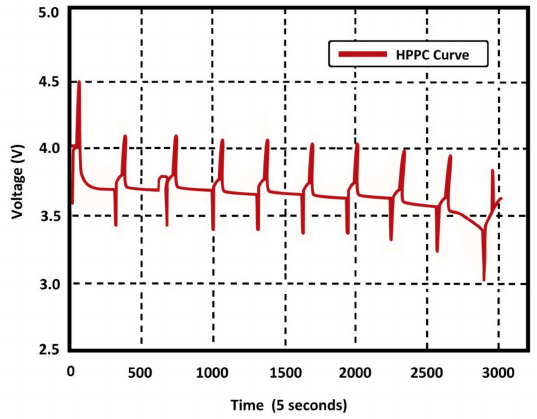
Figure 24. The output voltage of the battery used in Reference [24] when subjected to the HPPC